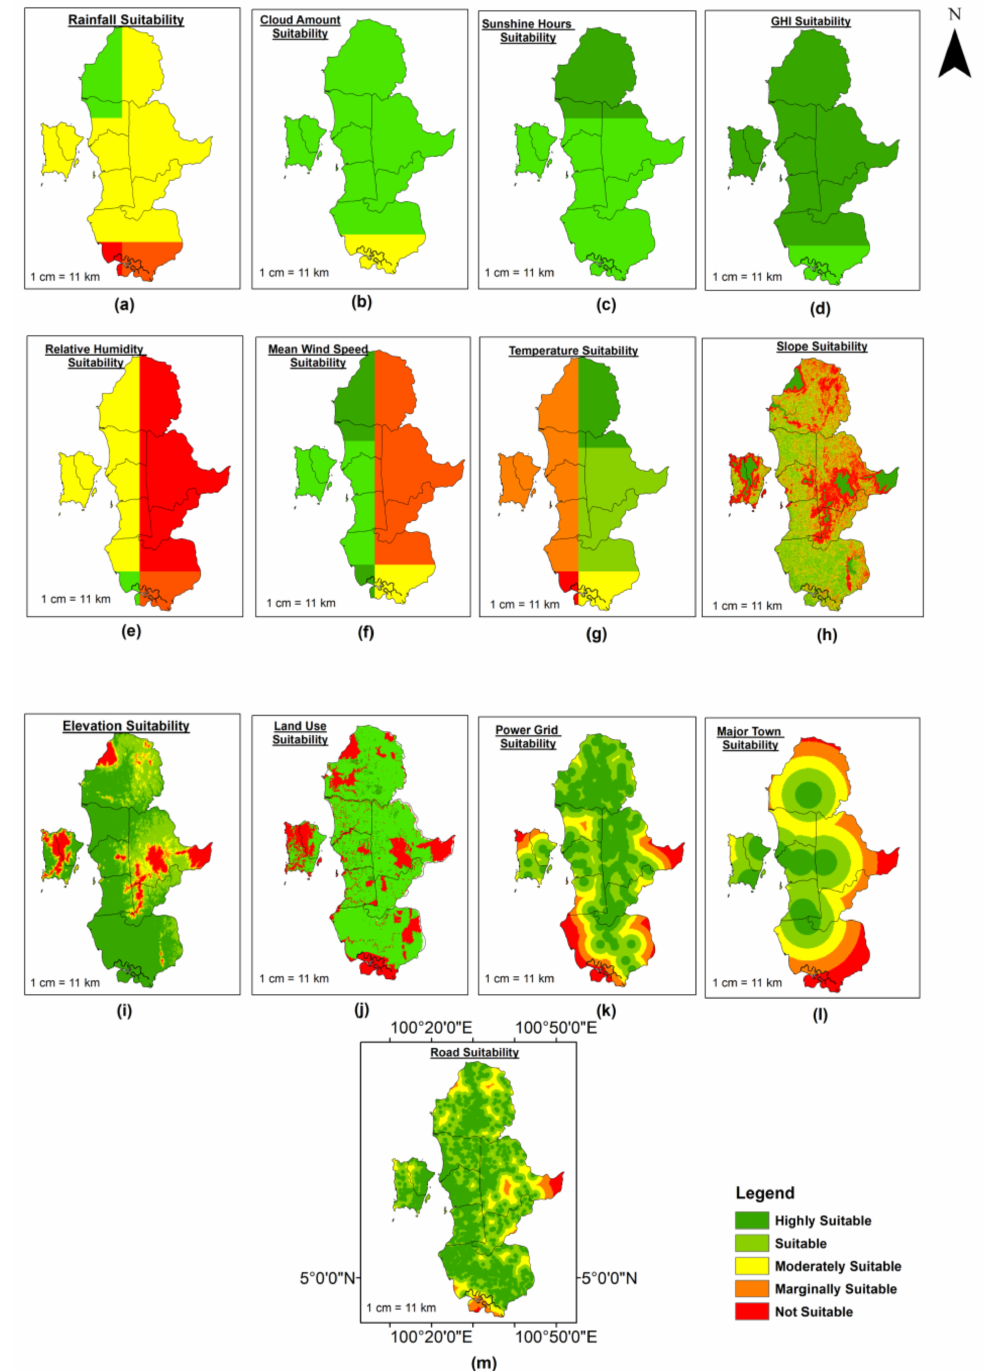
Figure 4. Suitability scoring for each criterion used in this study. ( a ) rainfall suitability, ( b ) road suit- ability, ( c ) distance to the urban area suitability, ( d ) distance to the power lines suitability, ( e ) relative humidity suitability, ( f ) mean wind speed suitability, ( g ) cloud cover suitability, ( h ) GHI